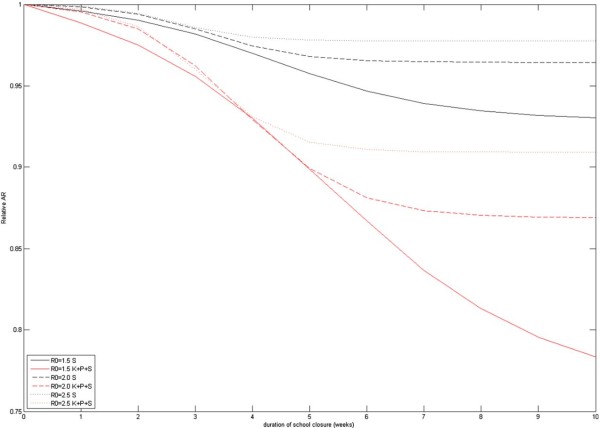
The relative attack rate compared to an unmitigated pandemic as function of school closure duration (number of closure weeks).